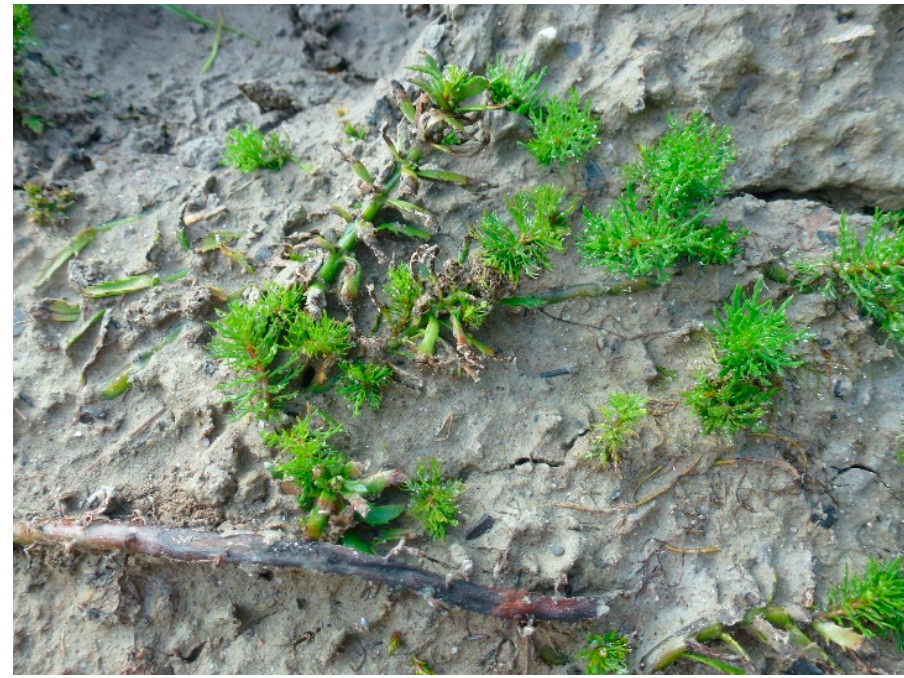
Figure 4. The terrestrial growth form of Myriophyllum heterophyllum . Photo A. Hussner.